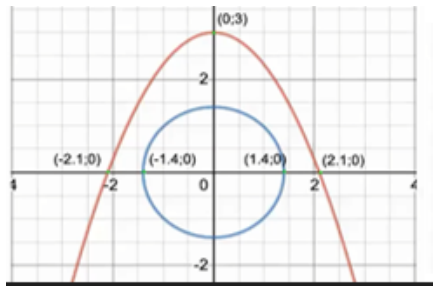
Figure 8. Integrals used to determine the area